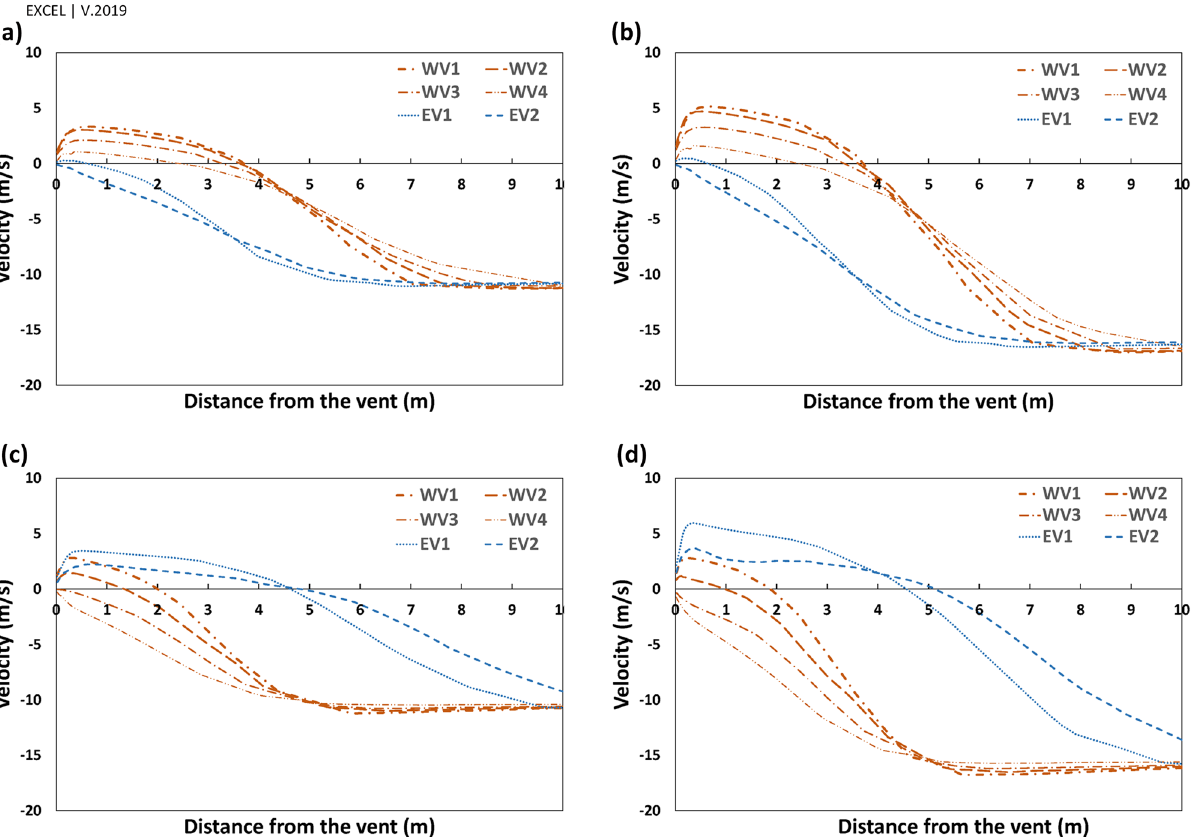
Figure 14. V y ′ on the perpendicular profiles to western and eastern vents in scenarios ( a ) Sc17-10, ( b ) Sc17-15, ( c ) Sc30-10 and ( d ) Sc30-15.